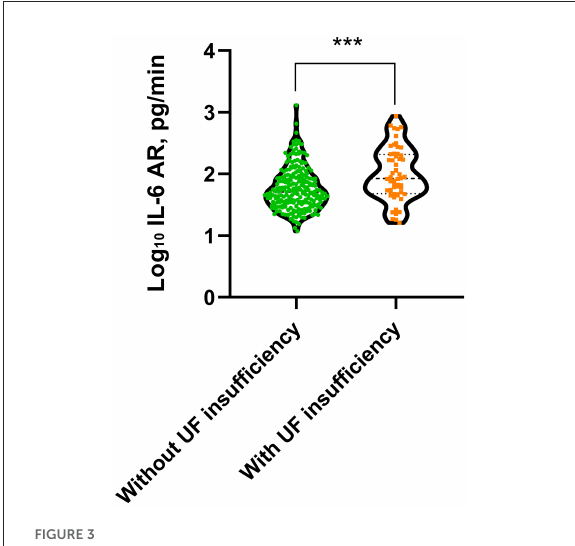
FIGURE3 Dialysate IL-6 AR level in patients with or without UF insufficiency ( *** p < 0.001). Non-parametric data were compared using Mann–Whitney test. UF, ultrafiltration; AR, appearance